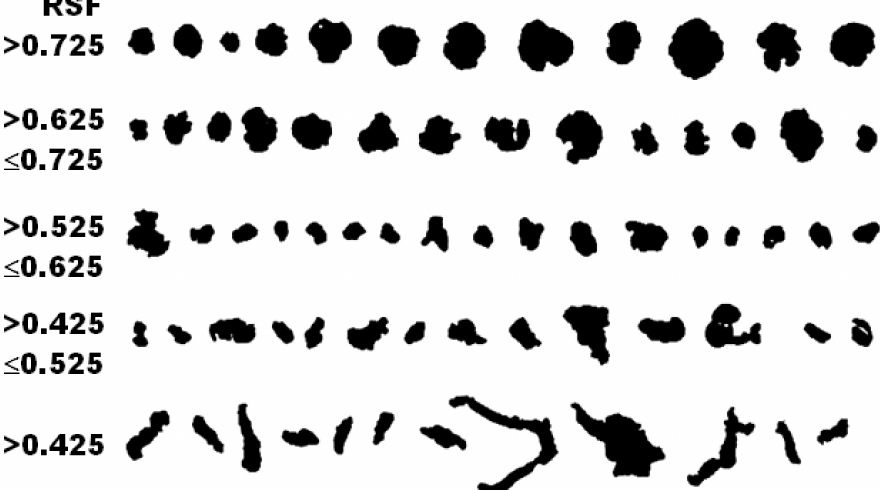
Figure 11. Visual representation of graphite particles categorized using RSF, according to ISO